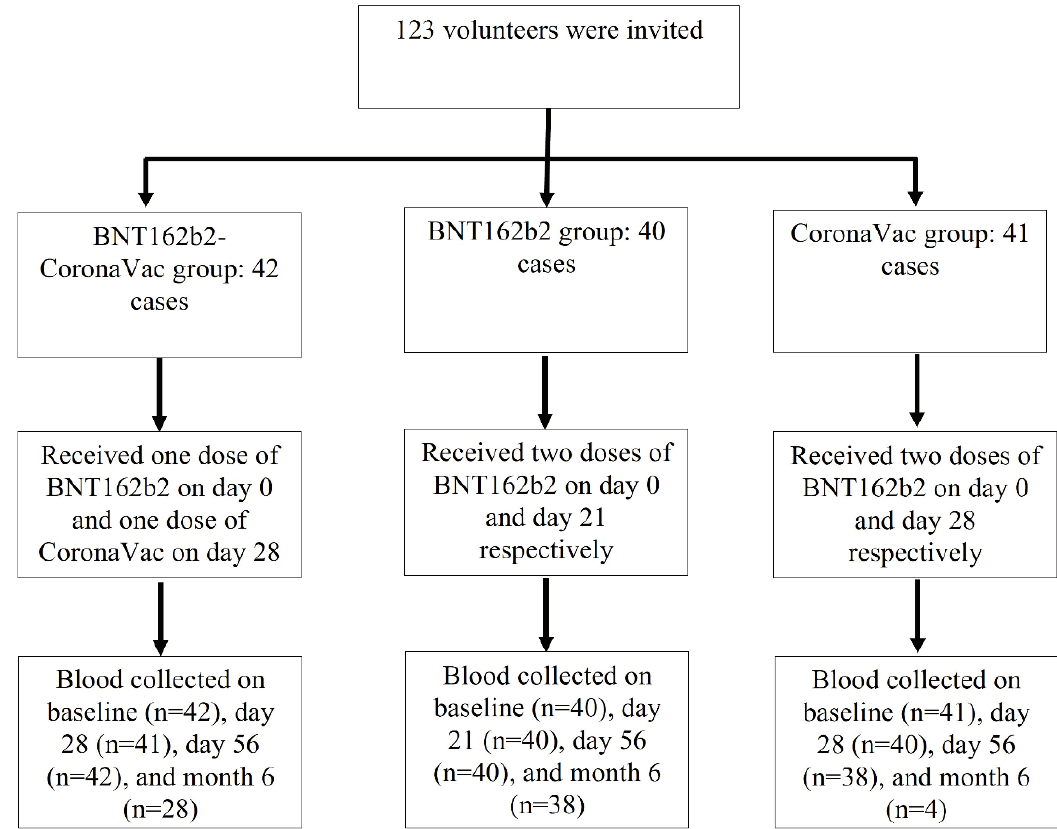
Figure 1. Participant recruitment and research flow diagram.